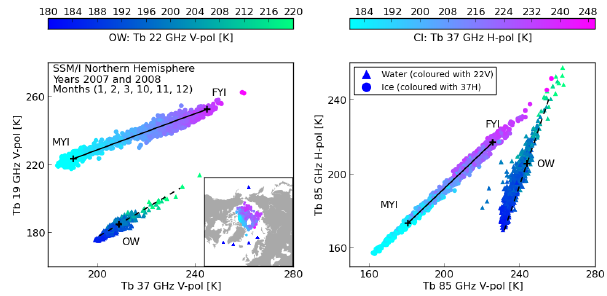
Figure 1. Coverage graphs for the SSM/I subset of the North- ern Hemisphere’s round robin data package (RRDP) in winters 2007 and 2008. Both brightness temperature (Tb) and spatial cov- erage are displayed. Open water (OW) and closed ice (CI) locations are shown by triangle circle symbols respectively. In the Tb dia- grams, the OW symbols are coloured according to Tb22V values (left colour scale), while the CI symbols are coloured according to Tb37H values (right colour scale) (also in the embedded map). Solid and dashed lines show ice and OW lines respectively. FYI – first year ice, MYI – multi-year ice.